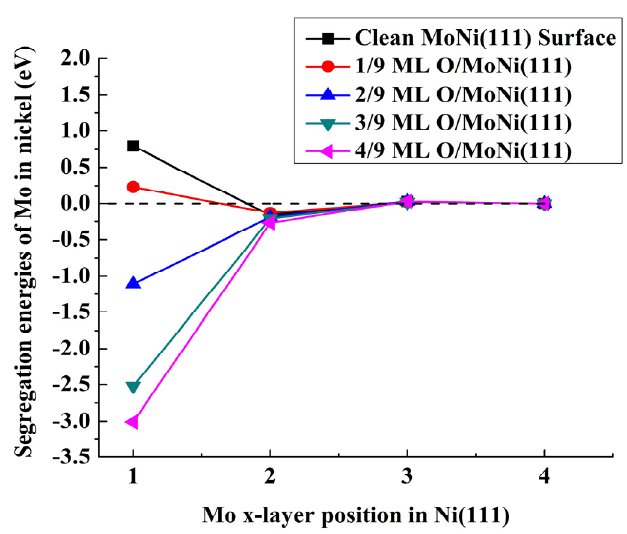
Figure 2. Top views of the most stable adsorption configurations for the oxygen coverage of ( a ) 1/9; ( b ) 2/9; ( c ) 3/9 and ( d ) 4/9 with Mo located at the top ‐ most atomic layer of the slab. Only the top ‐ most metal atomic layer and adsorbed O atoms are shown. Gray, blue and red balls represent Ni, Mo and O, respectively.